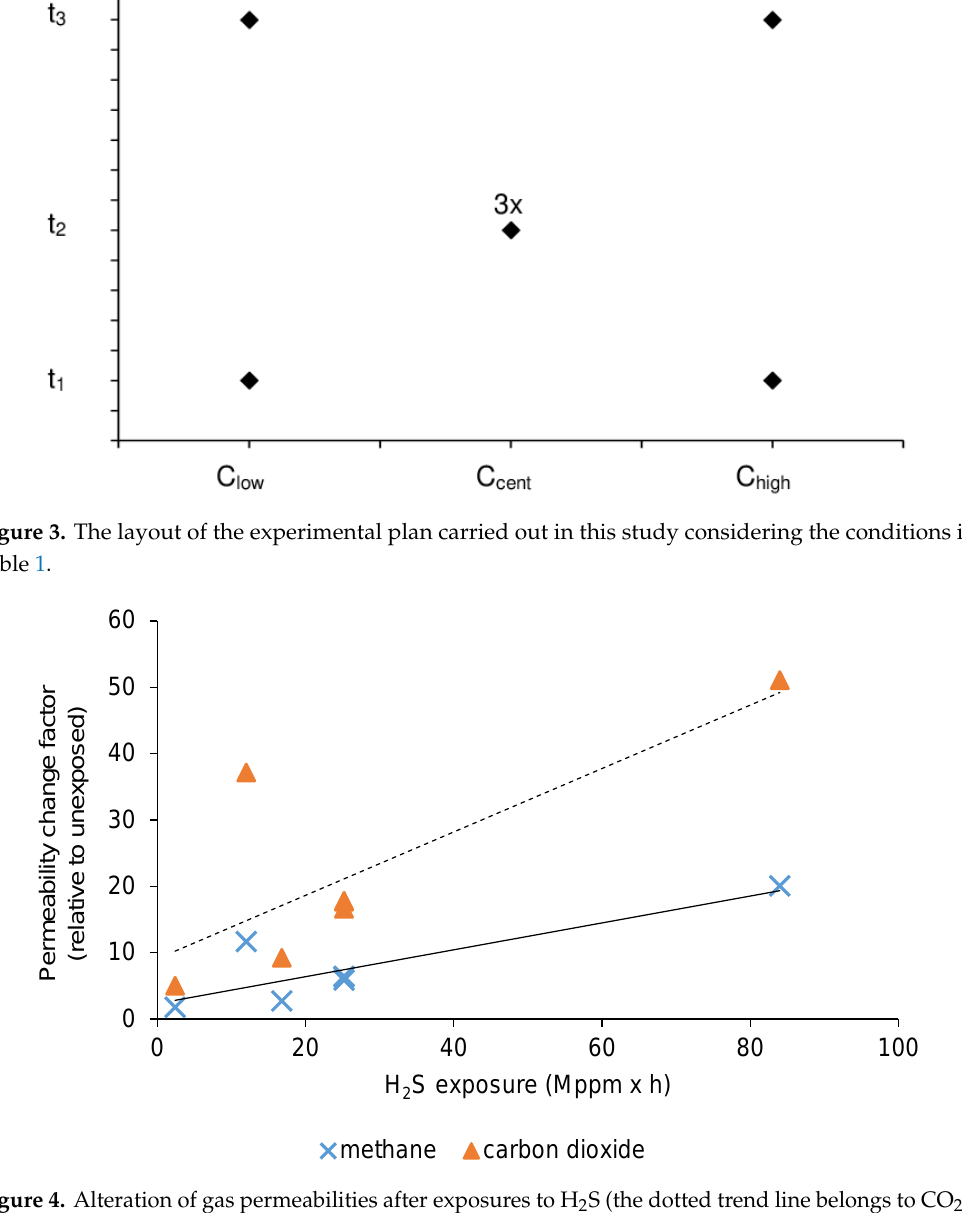
Figure 4. Alteration of gas permeabilities after exposures to H 2 S (the dotted trend line belongs to CO 2 ).